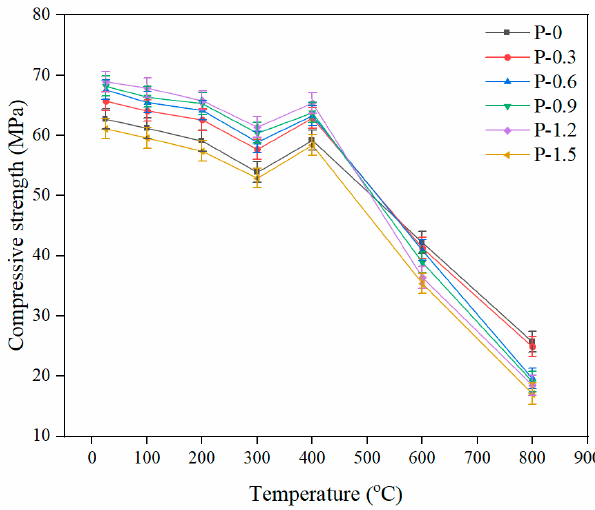
Figure 4. Compressive strength of PVA-FRCC specimens with different fiber contents.